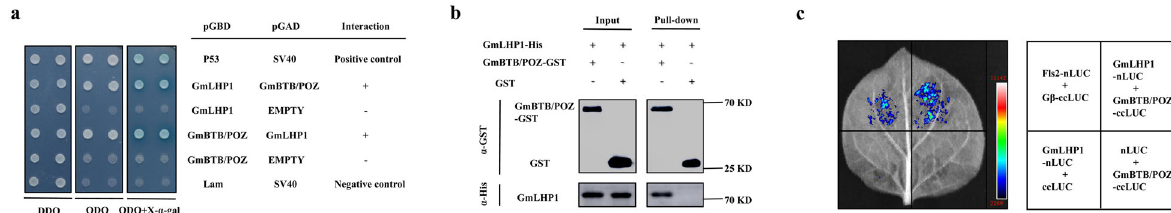
Fig. 1 GmLHP1 interacts with GmBTB/POZ. a GmLHP1 interacts with GmBTB/POZ in yeast cells. The yeast cells were selected on SD medium lacking Leu and Trp (DDO), and interaction was assessed based on their ability to grow on selective SD medium lacking Leu, Trp, His, and Ade (QDO) or SD medium lacking Leu, Trp, His, and Ade (QDO) but containing X- α -Gal for 3 days at 30 °C. The combination of pGBD-P53 + pGAD-SV40 was used as a positive control and pGBD-Lam + pGAD-SV40 as a negative control. X- α -Gal represents 5-bromo-4-chloro-3-indolyl- α - D -galactoside. b In vitro pull-down assays showing the interactions of GmLHP1 with GmBTB/POZ. His-tagged proteins were incubated with immobilized GST or GST-tagged proteins, and immunoprecipitated fractions were detected by anti-His antibody. c Interaction between GmLHP1 and GmBTB/POZ in LCI assays. The combination of Fls2- nLUC + G β -ccLUC was used as a